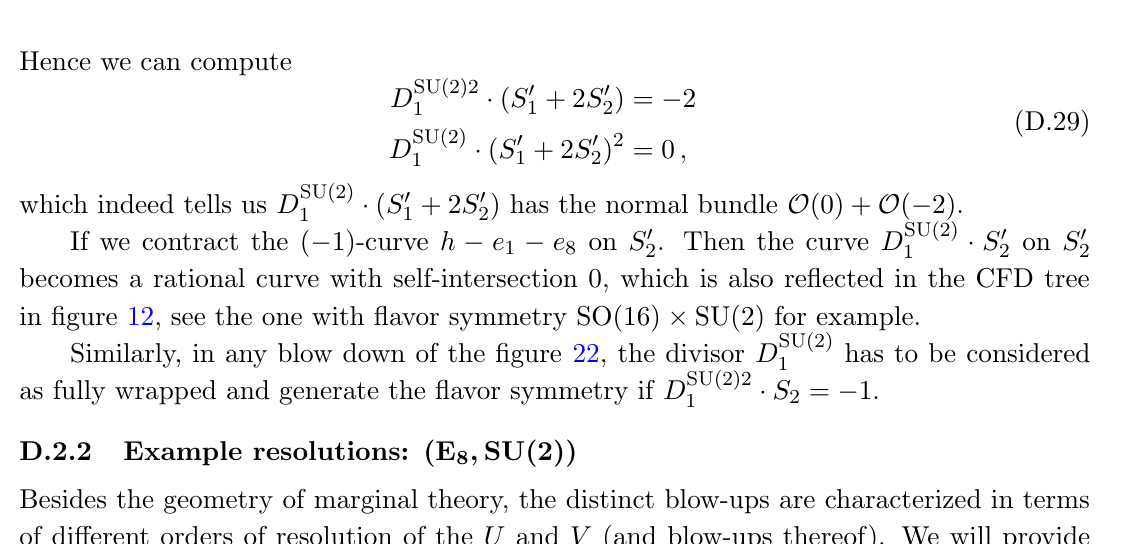
Figure 22 . The con(cid:12)guration of curves on S 0 the (cid:13)op. The number in the bracket denotes the self-intersection number of the curve. The letter denotes an intersection curve with the corresponding divisor in the resolved Calabi-Yau